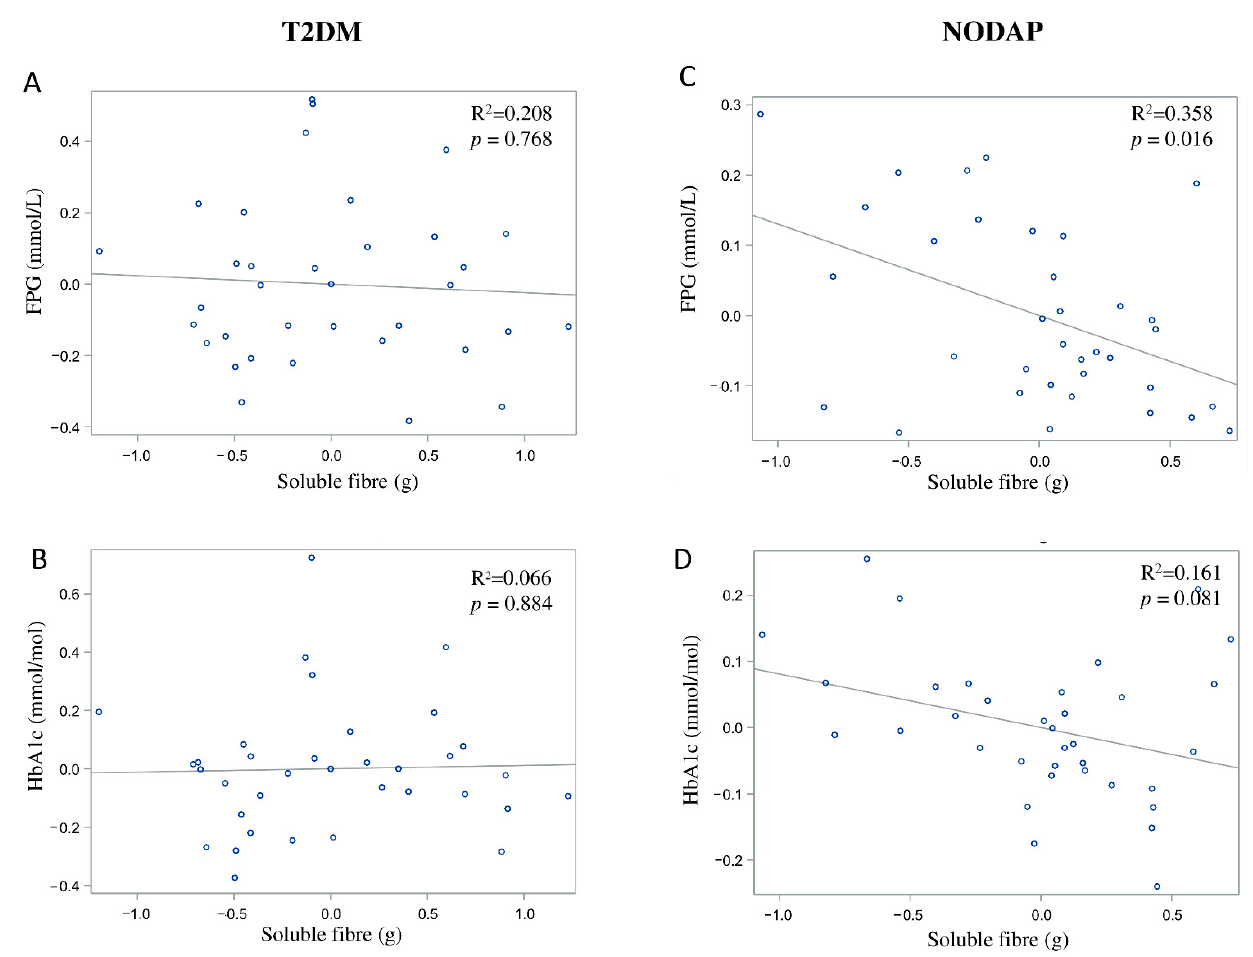
Figure 3. Associations between soluble fibre intake and makers of glucose metabolism between T2DM ( A , B ) and NODAP group ( C , D ). Abbreviations: T2DM = Type 2 diabetes or prediabetes prior to acute pancreatitis. NODAP = New-onset diabetes or prediabetes after acute pancreatitis. HbA1c = glycated haemoglobin. FPG = fasting plasma glucose. R 2 = adjusted R 2 value (coefficient determinations). Footnotes: FPG, HbA1c, and soluble fibre were log-transformed. R 2 values were adjusted for age, sex, BMI, energy intake (log-transformed), use of anti-diabetic medications, aetiology of pancreatitis, recurrence of pancreatitis, and presence of pancreatic necrosis.